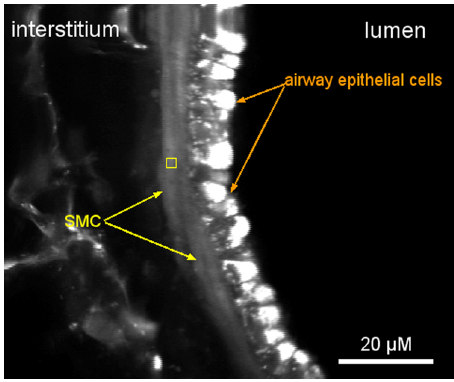
Figure 2. Fluorescence image of part of a mouse airway wall obtained by two-photon laser scanning microscopy. The yellow square shows a typical region, within an ASMC, from which Ca 2 z dynamics is